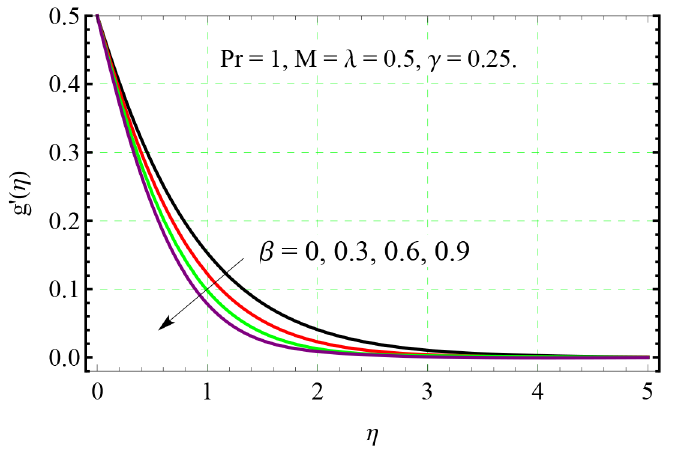
Fig 4. Effect of β on g 0 ( η ).